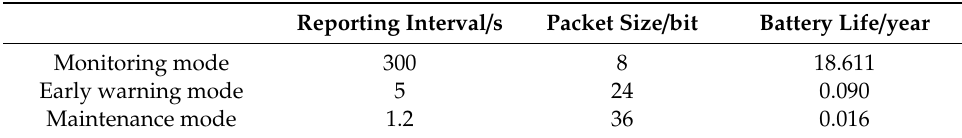
Table 5. Service life of three working